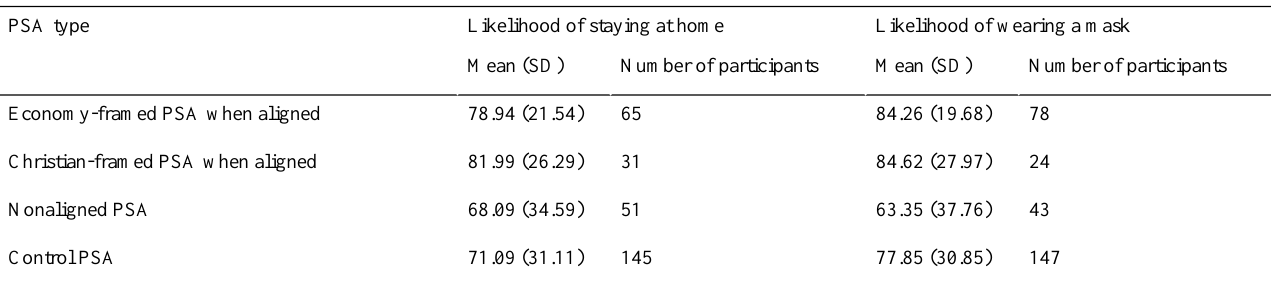
Table 1. Means for the likelihood of complying with public service announcements (PSAs). Data were collected in July 2020 from 292 participants from Amazon Mechanical Turk, who viewed two PSAs: 1 advocating wearing a mask and 1 advocating staying at home. One PSA was an information-based control PSA and the other was a Christian or economically motivated identity–framed PSA.